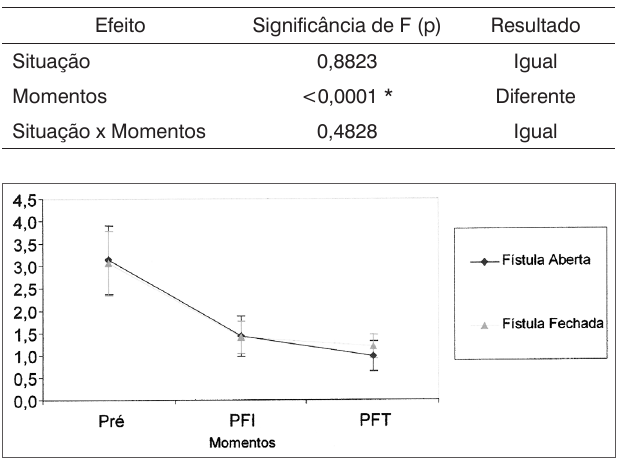
Tabela 2. Resultados do Teste de Análise de Variância (ANOVA) para a amplitude do PS